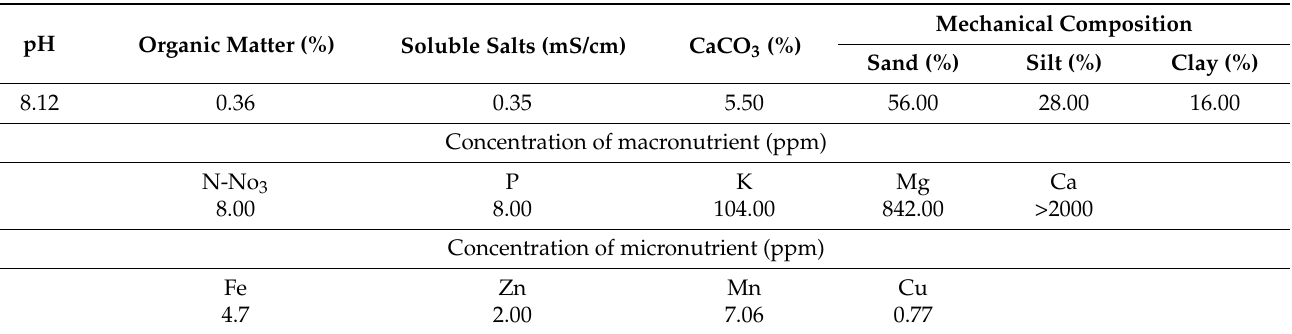
Table 1. Chemical and physical properties of the soil used in pilot cultivation of Teucrium luteum subsp. gabesianum